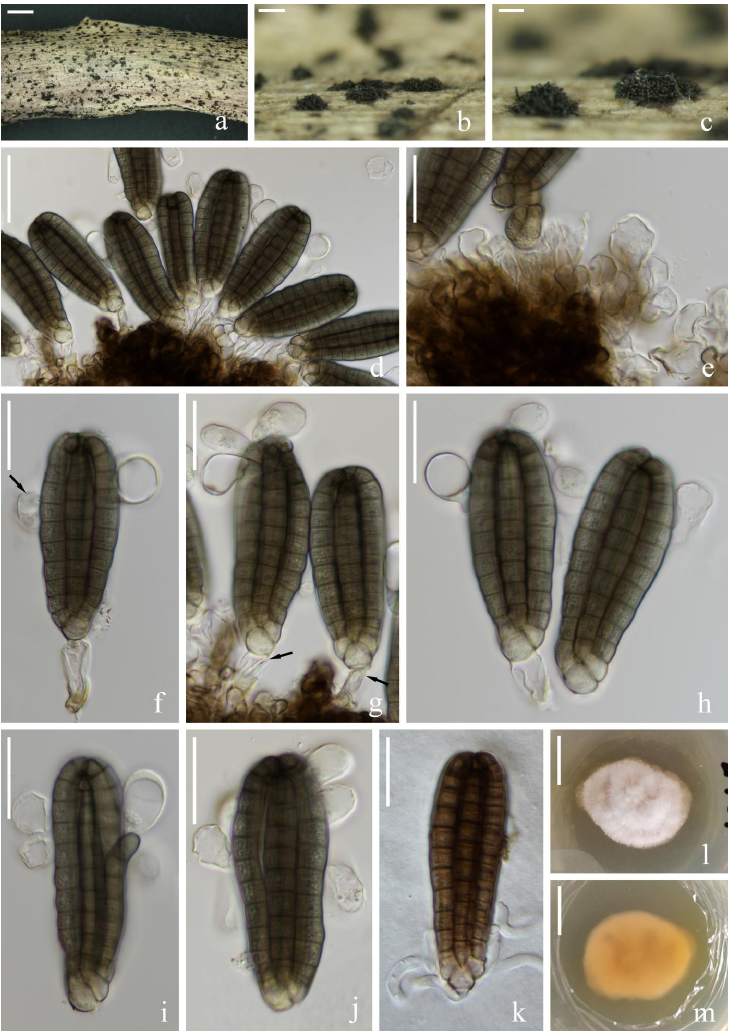
Figure 4. Dictyocheirospora multiappendiculata (KUN-HKAS 122866, holotype). ( a – c ) Colonies on the substratum. ( d ) Conidiomata and conidia. ( e ) Conidiophores and conidiogenous cells. ( f – h ) Conid- iogenous cells, conidia and appendages. ( i , j ) Conidia with appendages. ( k ) Germinating conidium. ( l , m ) Culture colonies on PDA, reverse (upper) and obverse (lower). Scale bars: ( a ) 2000 μ m, ( b ) 200 μ m, ( c ) 100 μ m, ( d ) 30 μ m, ( e – k ) 20 μ m and ( l , m ) 1 cm. Dictyocheirospora heptaspora (Garov.) M.J. D’souza, Boonmee & K.D. Hyde, Fungal Di- versity 80: 469 (2016), Figure 7.